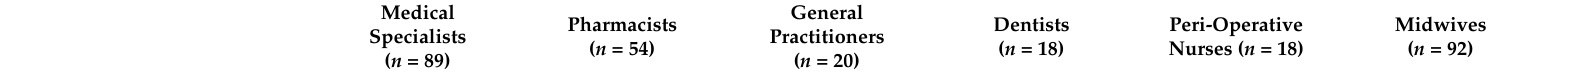
Table 2. Beliefs about breastfeeding and its health benefits. Data shown as number